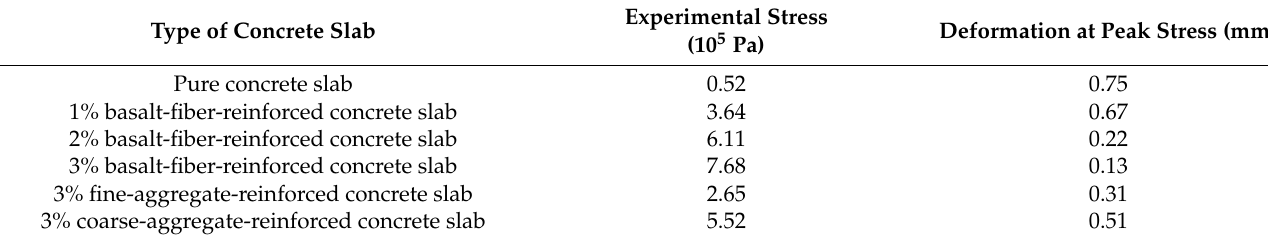
Table 3. Experimental results for the mechanical behavior of concrete.